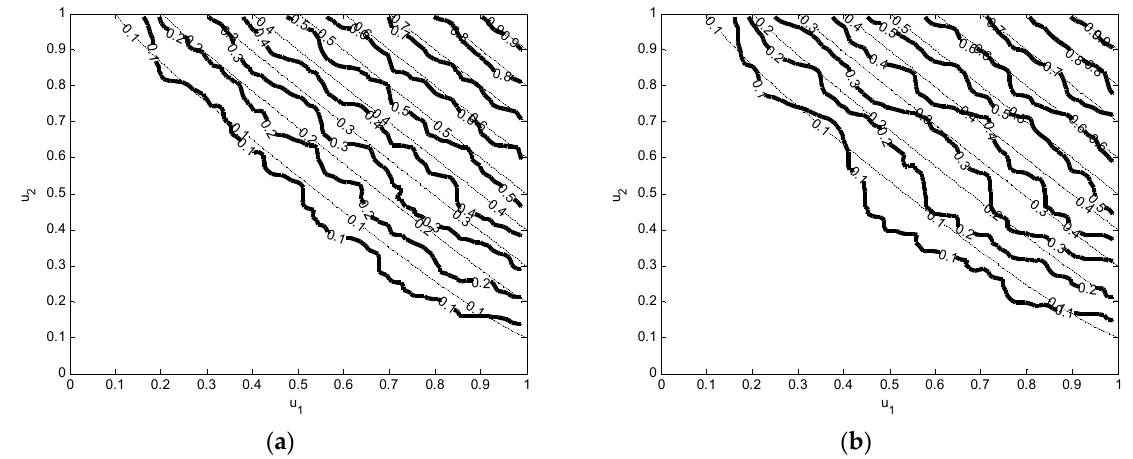
Figure 3. Contour plotting of empirical vs . theoretical copula at: ( a ) Monreale; ( b ) Palazzolo Acreide. In particular, Figure 3 shows the contours of the empirical copula (bold lines) plotted together with the theoretical copula (thin lines), while Figure 4 reports the comparison in terms of shaded surfaces.